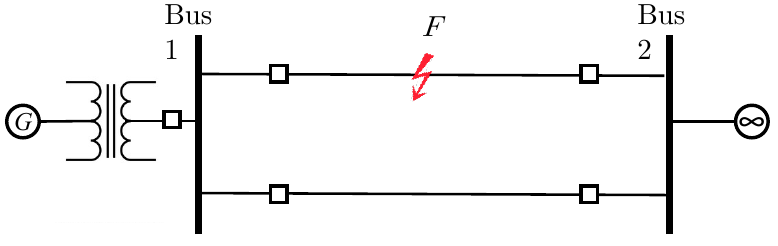
Figure 1. Single machine infinite bus